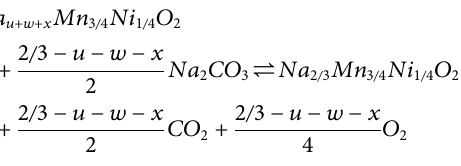
Figure 8 . The cells were cycled at C/10 (17.3 mA g − 1 ) for the